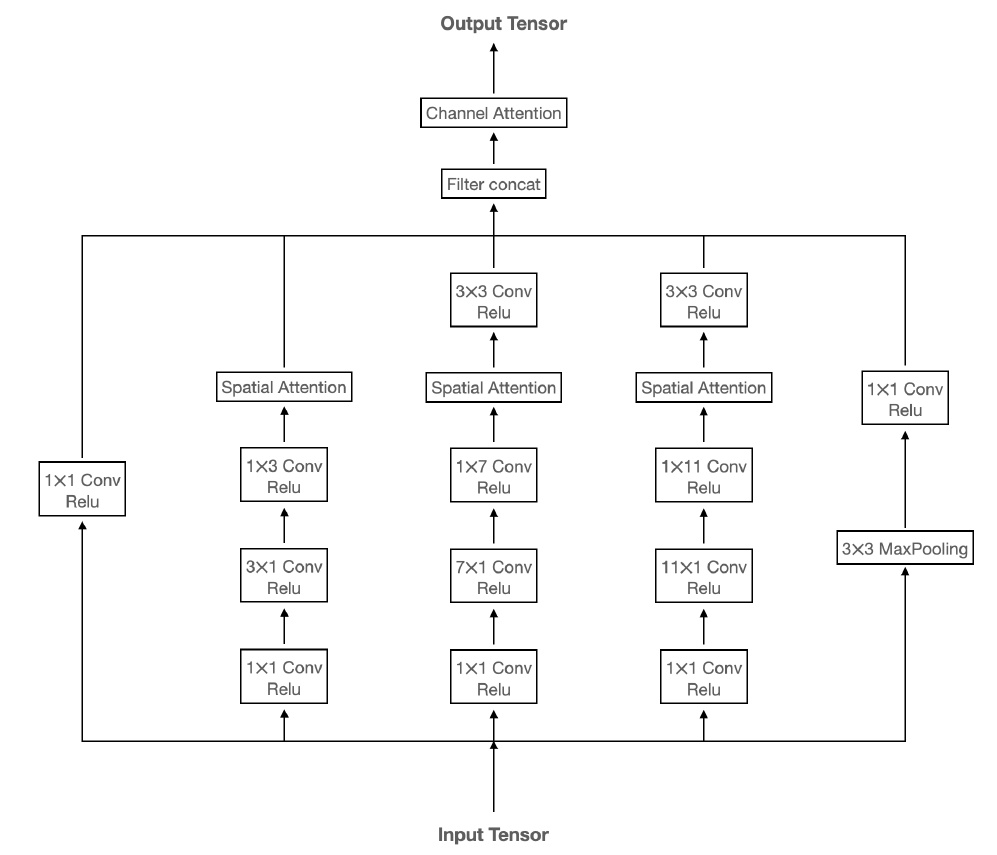
Figure 7. Inception-attention